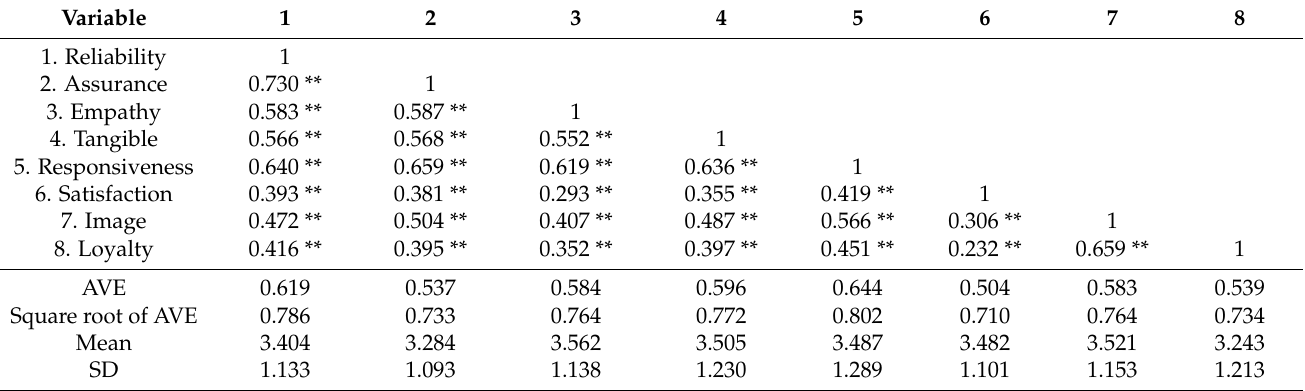
Table 3. The results of convergent validity and a correlation matrix of different